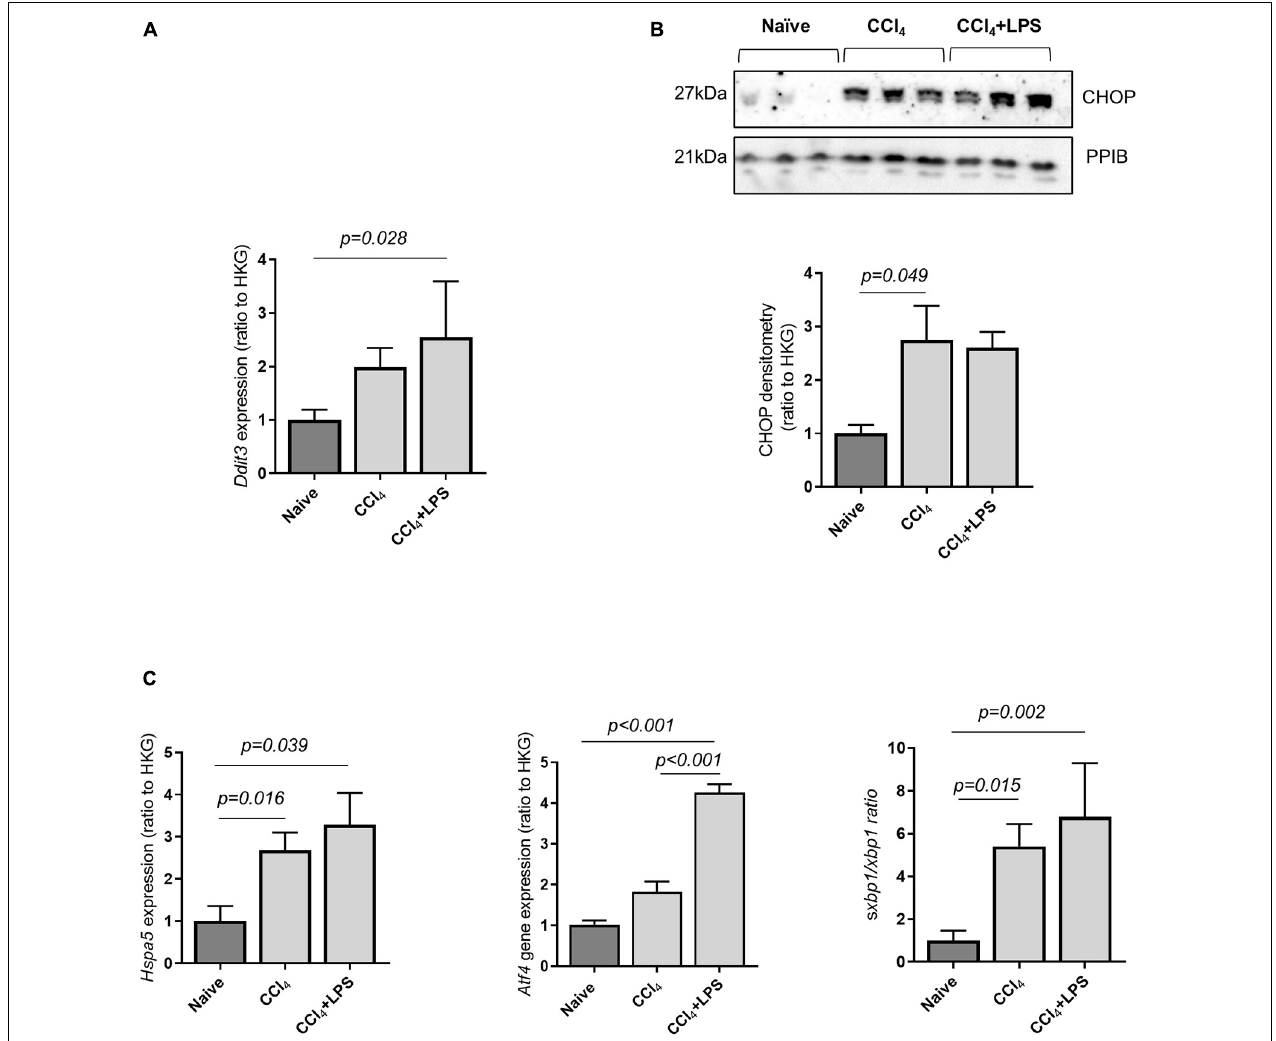
FIGURE 3 | Cirrhotic mice display increased hepatic endoplasmic reticulum stress. The expression of key genes involved in ER stress were measured by qPCR and/or Western blot from snap-frozen liver extract in CCl 4 -treated ( n = 7), and naïve ( n = 5) mice. The housekeeping gene ppib was used for normalization across experiments. (A) Gene expression of the ER-stress marker Ddit3 , coding for the protein CHOP, was increased in mice treated with CCl 4 + LPS (Dunn’s test, p = 0.028). (B) Protein expression of mature CHOP was significantly increased in the CCl 4 -treated group, compared to control (Dunn’s test p = 0.049). (C) Gene expression of Hspa5, Atf4, and ratio of spliced to unsplice xbp1 were significantly different across groups (one-way ANOVA: Hspa5 , p = 0.039; Atf4, p < 0.001; s Xbp1/Xbp1, p = 0.002).